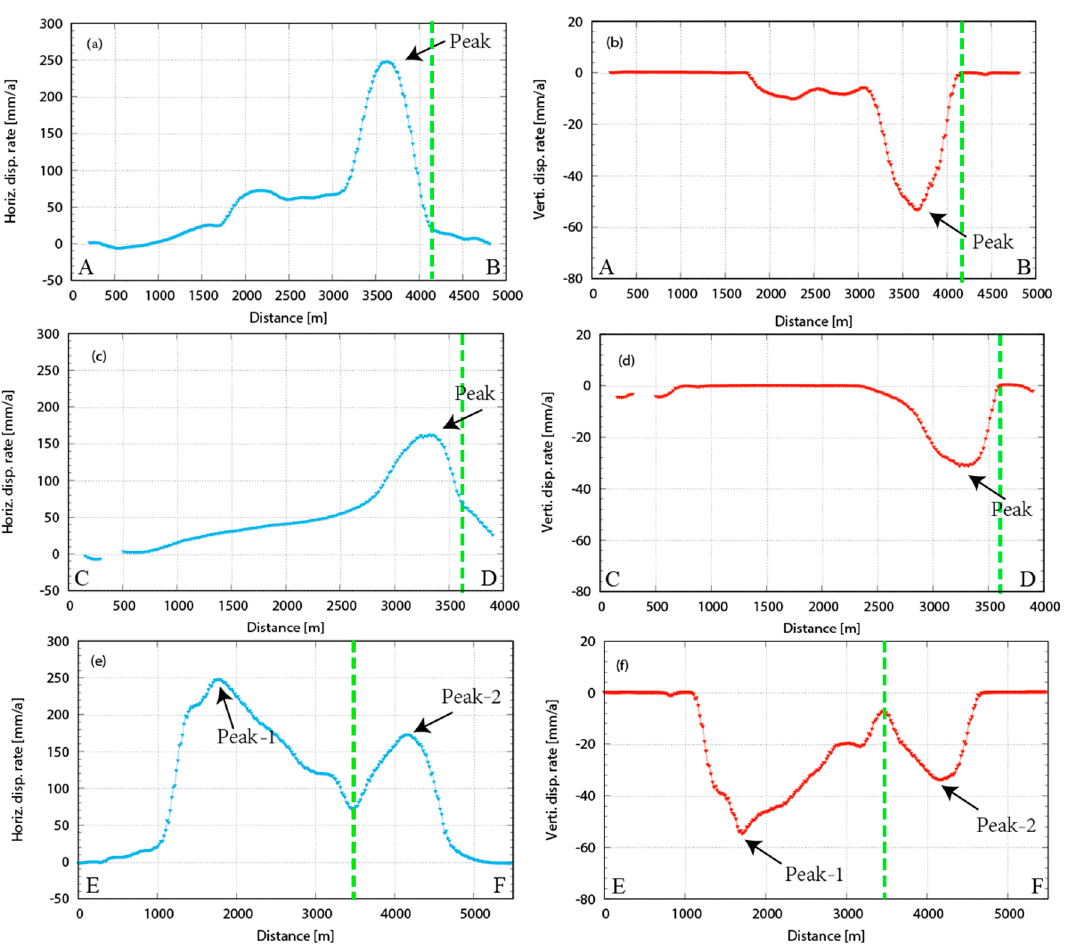
Figure 12. ( a ) is the horizontal displacement rate of pro fi le line A − B; ( b ) is the vertical displacement rate of pro fi le line A − B; ( c ) is the horizontal displacement rate of pro fi le line C − D; ( d ) is the vertical displacement rate of pro fi le line C − D; ( e ) is the horizontal displacement rate of pro fi le line E − F; ( f ) is the vertical displacement rate of pro fi le line E − F. The green line represents the suspected fault.